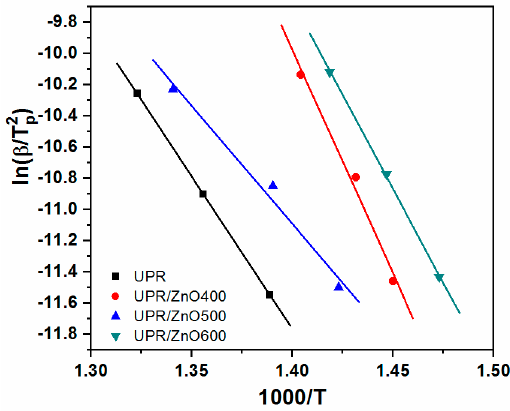
Figure 9. Isoconversion plot of the Kissinger method for UPR and nanocomposites.